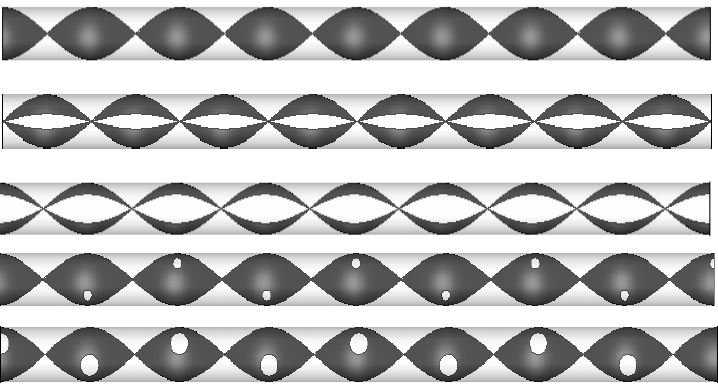
Fig. 2. The five twisted tapes schematics Fig .2 The five twisted tapes schematics